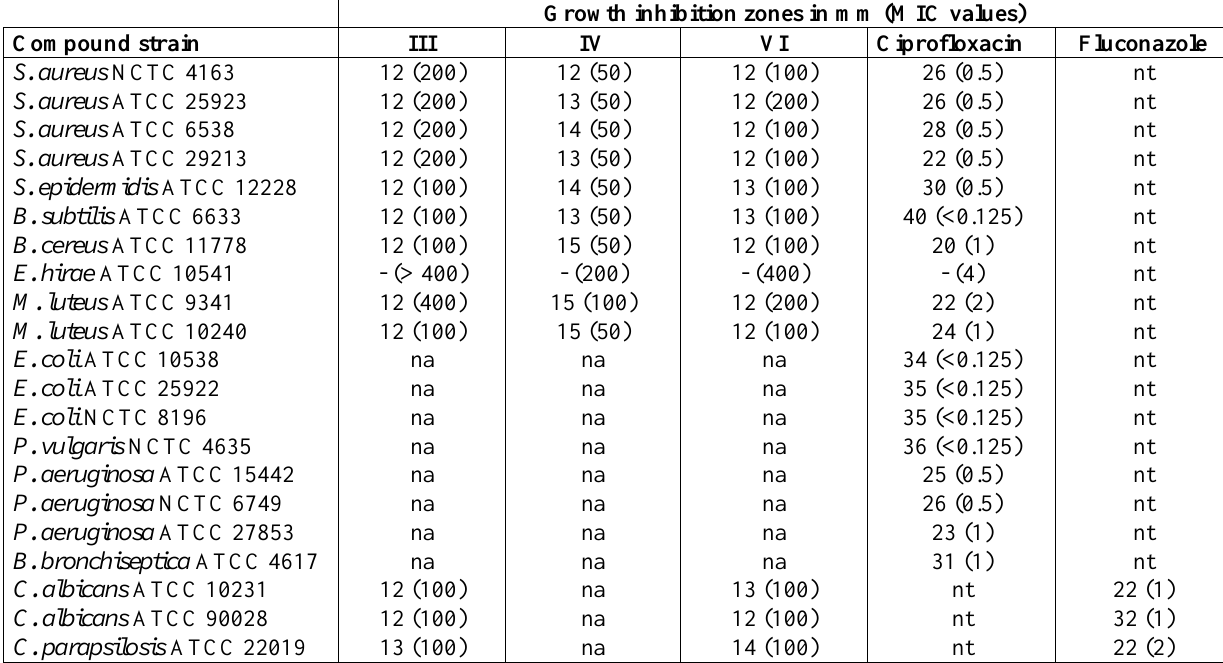
Table 3. Antimicrobial activity of derivatives III , IV , VI : diameter of the growth inhibition